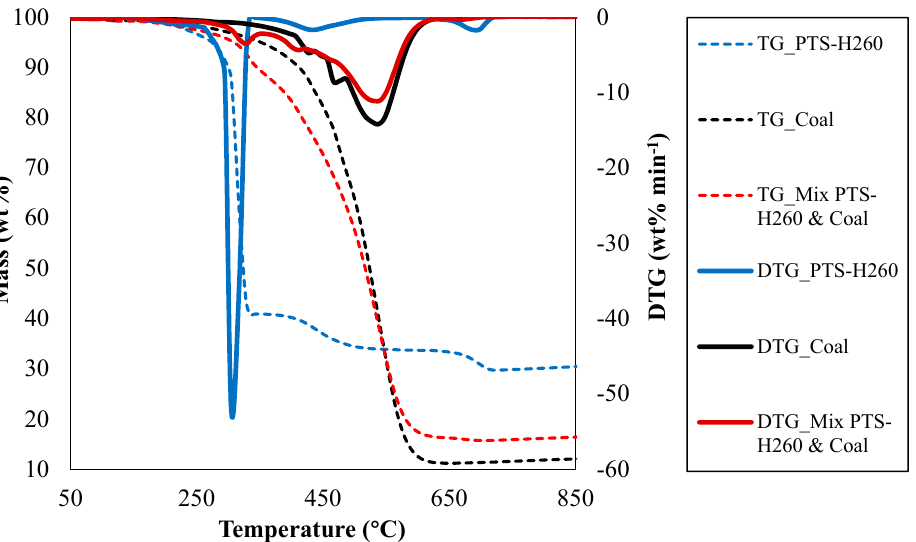
Figure 4. Combustion thermograph and DTG curves plotted versus temperature for 260 °C HTC treated paper mill sludges, coal and 50% mixtures of coal and hydrochar (TG nomenclature refers to mass loss on the left axis and DTG can be found on the right axis).